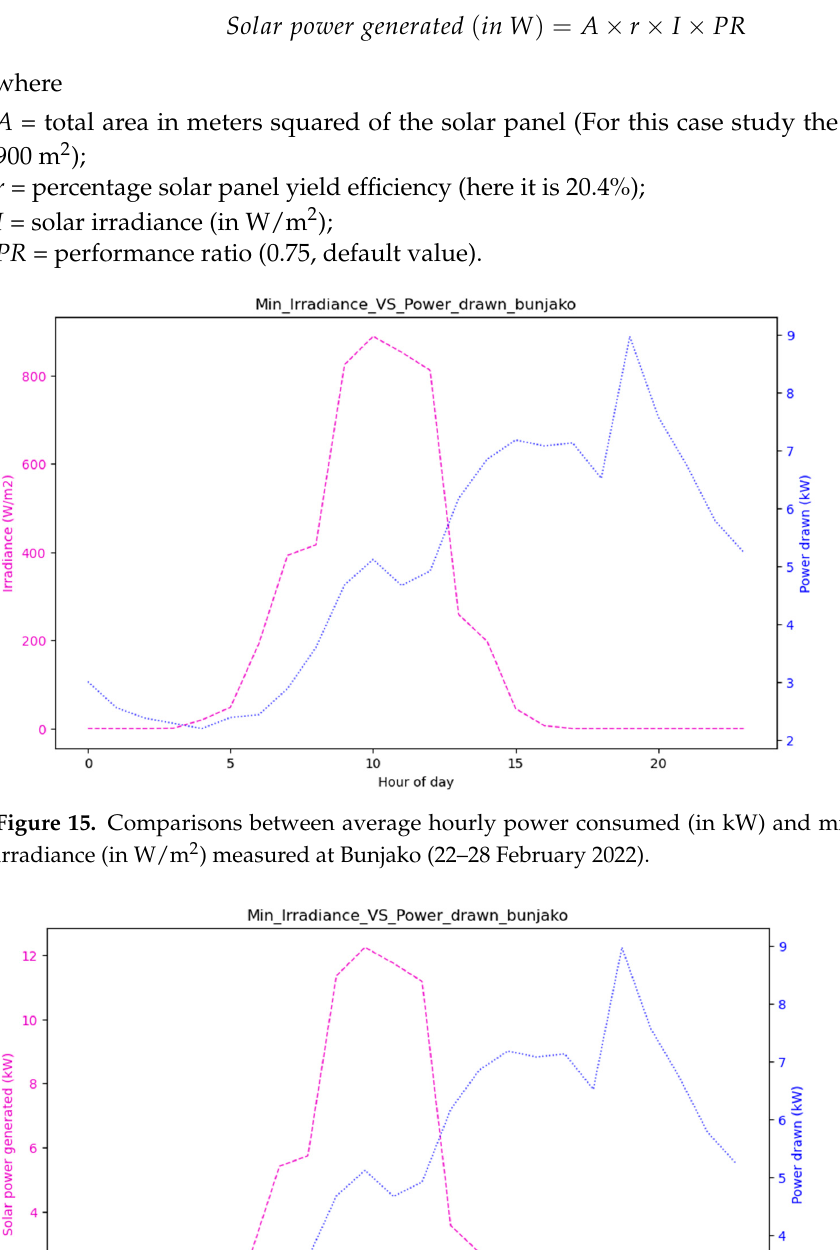
Figure 14. Measured irradiance (22–28 February 2022).